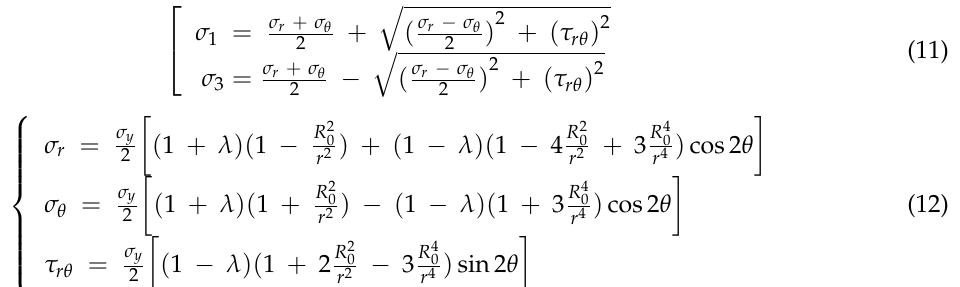
Figure 12b takes into account the water absorption softening of surrounding rock. In the horizontal direction, the plastic zone of the surrounding rock is elliptical, and the long axis is perpendicular to the maximum principal stress direction. Under the influence of incompatible deformation of surrounding rock, the soft rock stratum produces lateral additional stress on the hard rock stratum, which makes the plastic zone expand nonlinearly at the interface between the soft and hard rock strata. After the water softening of the surrounding rock, the plastic area of the surrounding rock increases due to tensile failure. Figure 12c,d shows that the failure of the concrete shaft lining is mainly shear failure. After water absorption softening, the plastic zone of the shaft lining increases